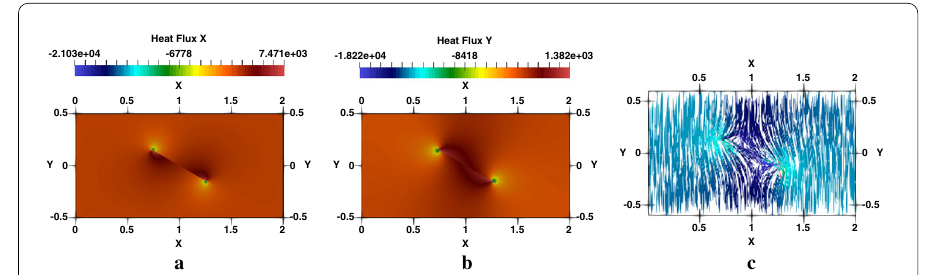
Fig. 9 Rectangular plate with inclined crack, β = 30 ◦ and a / W = 0 . 3: a q x -heat flux, b q y -heat flux, c flux lines